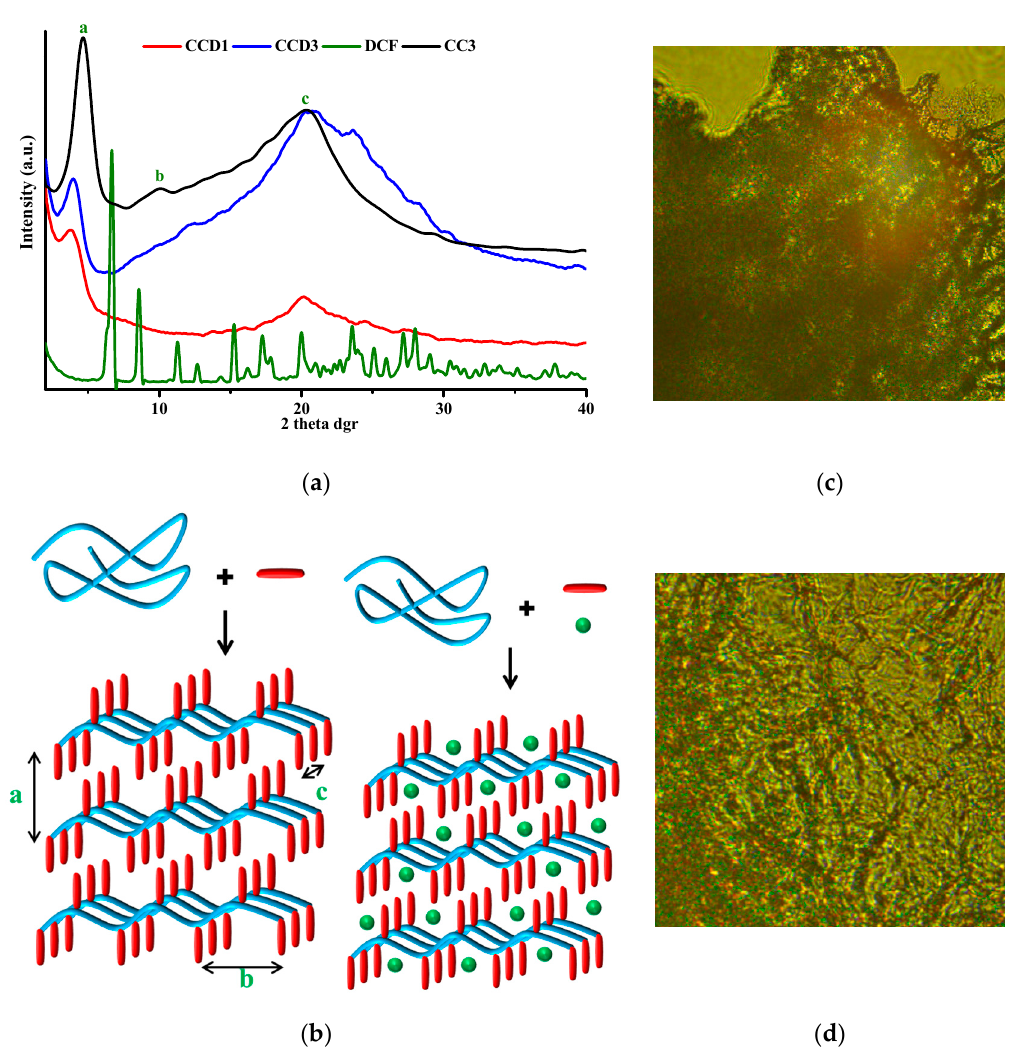
Figure 2. ( a ) Wide angle X-ray diffractograms of the xerogel sample CC3 , DCF, and drug delivery systems CCD1 and CCD3 ; ( b ) schematic representation of the supramolecular arrangement of the xerogels and drug delivery systems; and polarized optical microscopy (POM) images for ( c ) a representative reference hydrogel ( CC3) and ( d ) CCD3 .